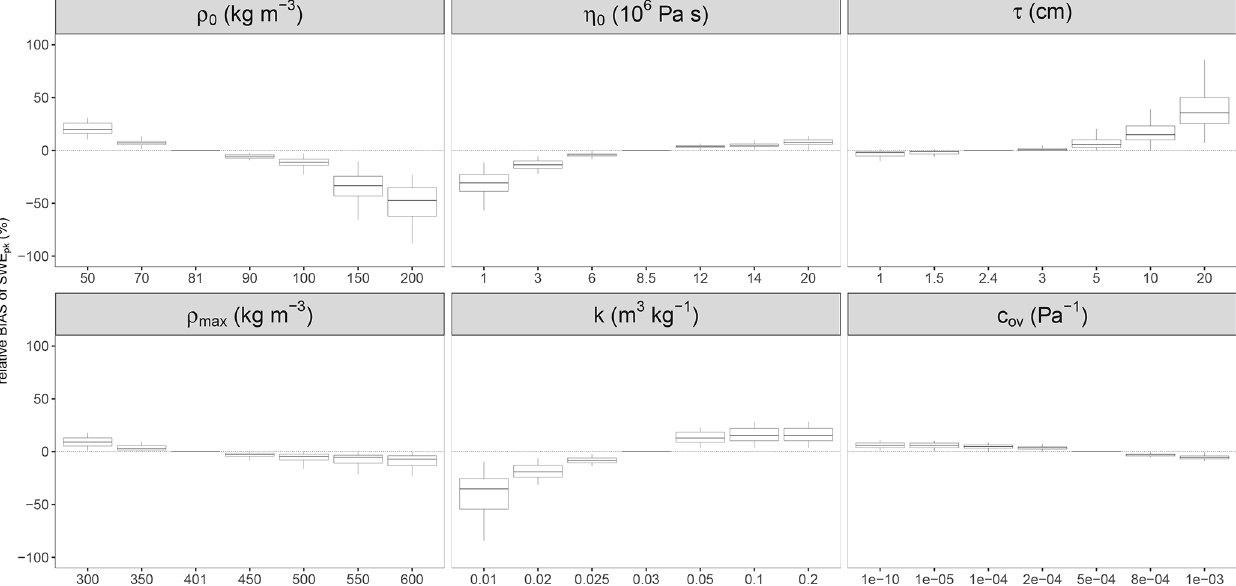
Figure 5. Sensitivity of SWE pk to changes in model parameters. The “relative bias of SWE pk ” is defined as the difference between SWE pk with best-fitted values and SWE pk with changed parameters (while all others are kept unchanged) divided by the best-fitted SWE pk . The boxes comprise SWE pk of all stations and all years of the validation dataset SWE val (71 values) and display medians as well as 25% and 75% percentiles; the whiskers indicate 1.5 times the interquartile range. For details and analysis, see the